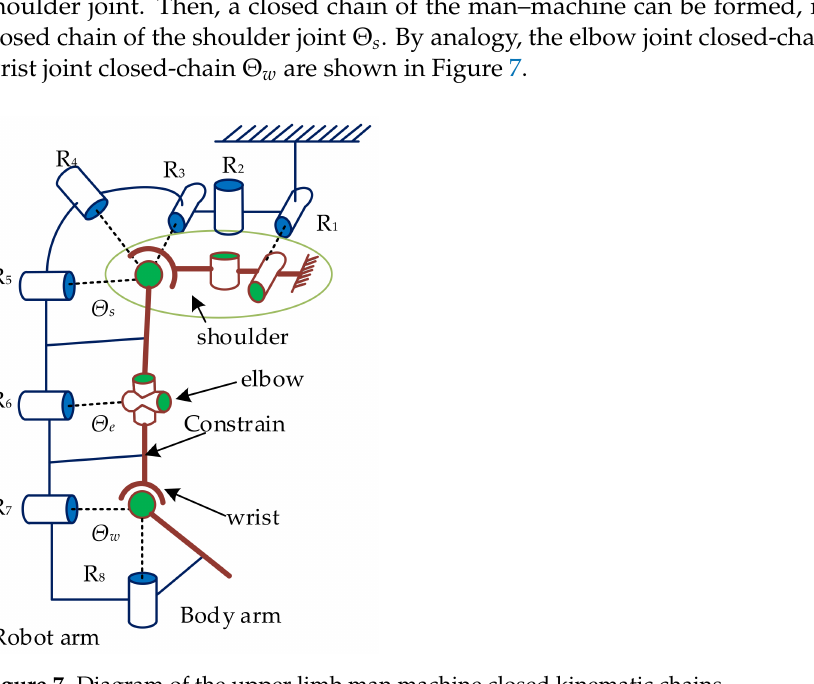
Figure 7. Diagram of the upper limb man machine closed kinematic